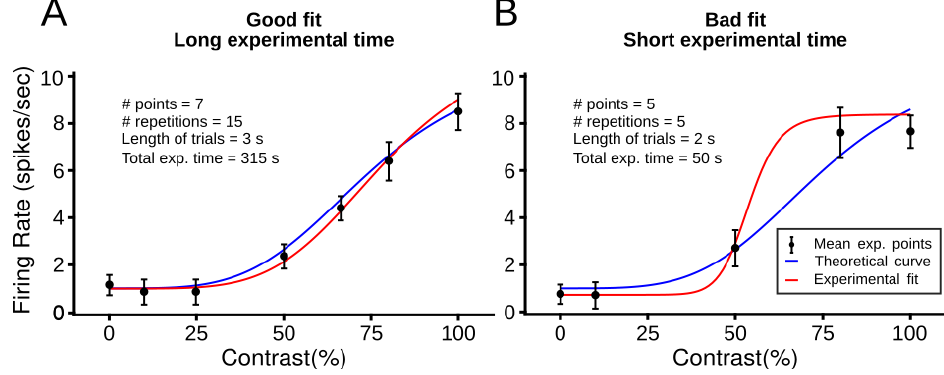
Figure 1. Trade-off between the fit performance and the recording time to obtain reliable CRFs. While the performance of the fit is measured by the comparison between theoretical and experimental curves, the recording time comes from the multiplication of experimental conditions (# points, # repetitions, length of trials). Theoretical curves (blue lines) are obtained directly by the NRE to a given set of parameters. Experimental curves (red lines) are generated by the fit of the average firing rate to visual contrast stimuli (black dots). Two representative cases are shown. ( A ) Comparison between theoretical and experimental CRFs provides a good curve fit (blue and red lines are similar), but the total experimental time is long. ( B ) The fit performance is poor since theoretical and experimental curves are substantially different, but the total acquisition time of the experiment is short.